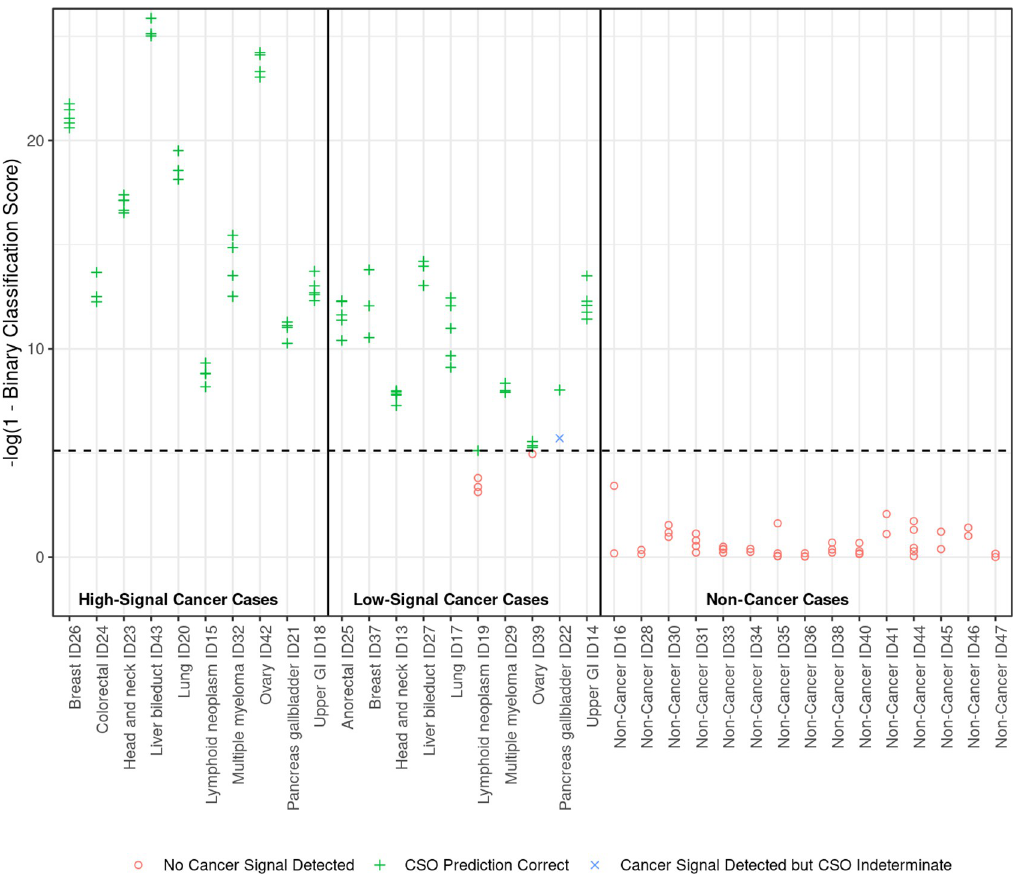
Fig 5. Binary classification scores of cancer and non-cancer samples were visually clustered in 3 groups. The binary classification score of a sample is the percentile of its classifier-derived score among non-cancer samples in the training set. Binary classification scores were log transformed as shown on the y-axis to facilitate visualization. The horizontal dotted line indicates the threshold score used to call samples as cancer (indicated with a “+” if tissue of origin was predicted correctly or “ × ” if it was predicted as indeterminate) or non-cancer (red open circles). GI, gastrointestinal; ID, sample identifier.